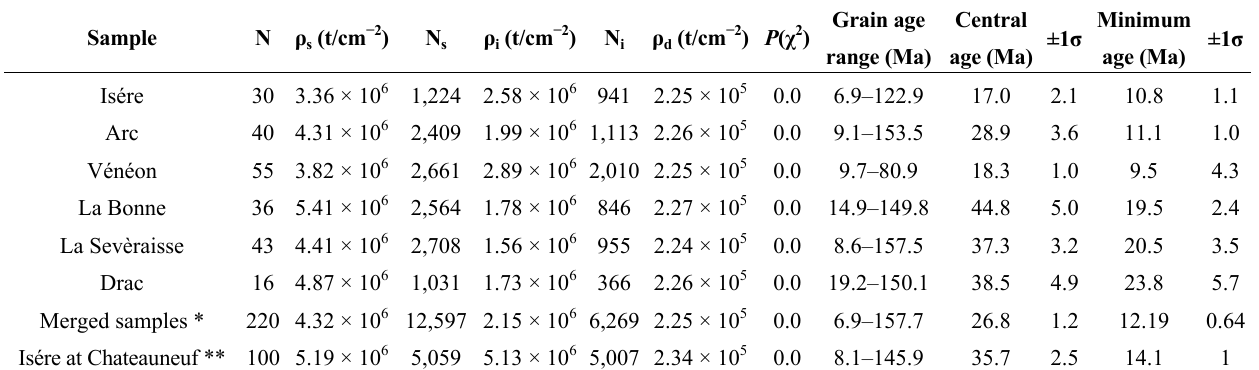
Table 2. Detrital zircon fission-track data of the Isère River